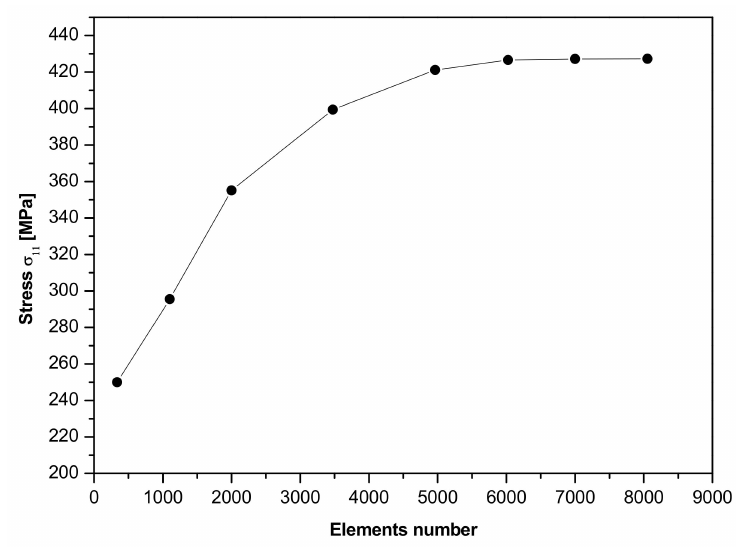
Figure 6. Convergence curve of principal stress σ 11 at angle θ = π /2.